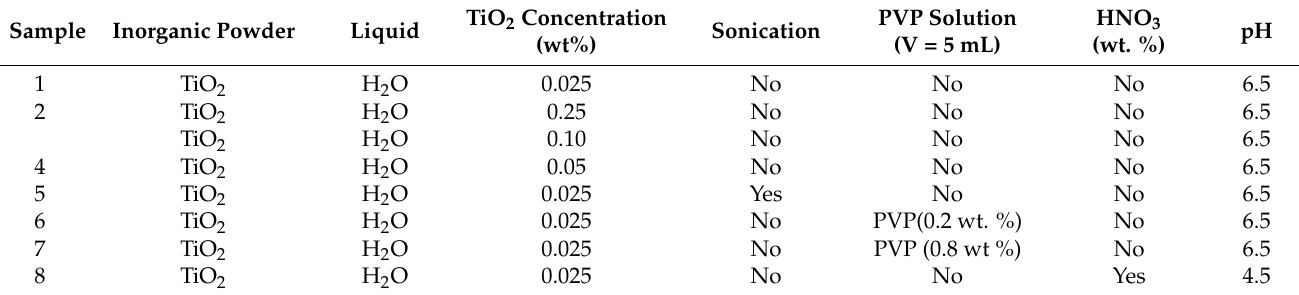
Table 1. Composition of the titanium dioxide